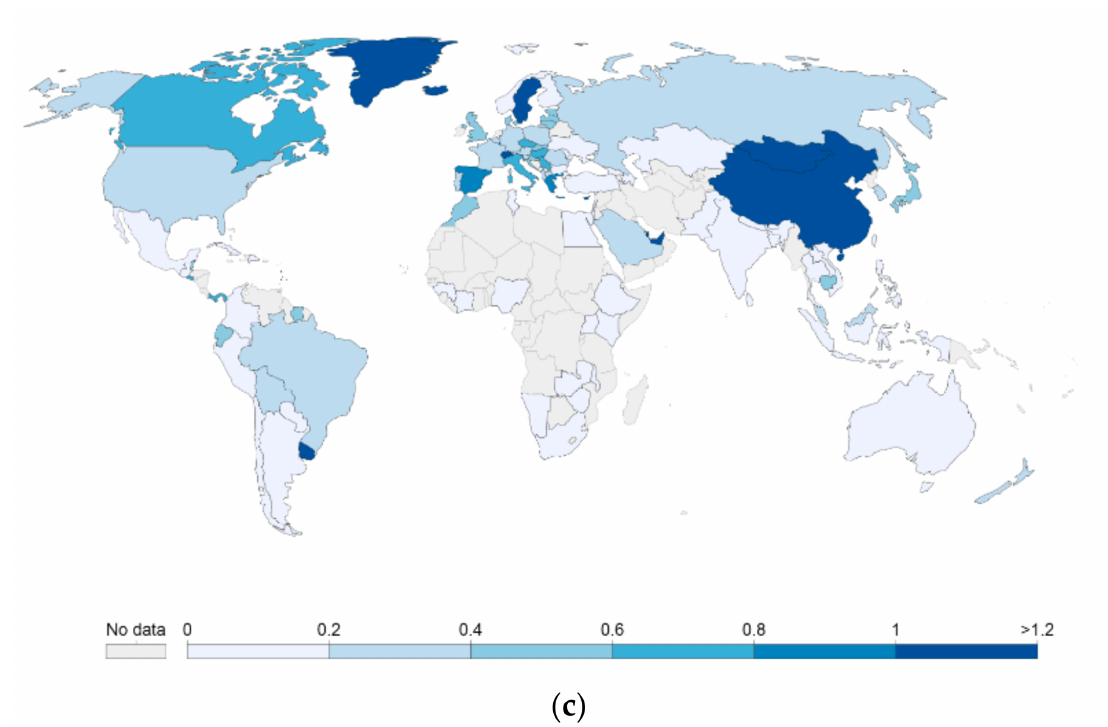
Figure 10. COVID-19 vaccine per day doses administrated average per 100 people in a country’s total population in different Asian countries. Data counted single-dose vaccine doses administered per 100 people in the total population up to 24 May 2021. ( a ) COVID-19 vaccine per day doses administration data (doses administered per 100 people) in different Asian countries represented through a linear graph. ( b ) COVID-19 vaccine per day doses administrated data (doses administered per 100 people) in various Asian countries represented through the log graph. ( c ) COVID-19 vaccine per day doses administration data (doses administered per 100 people) in different Asian countries represented through the Asian map (Data source: Our World in